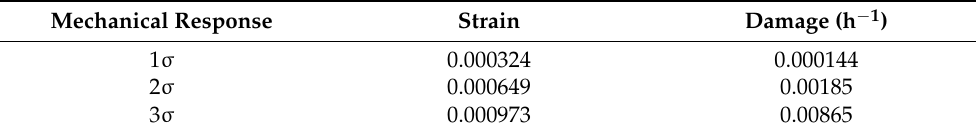
Table 9. The mechanical response of the dangerous node under the random vibration.